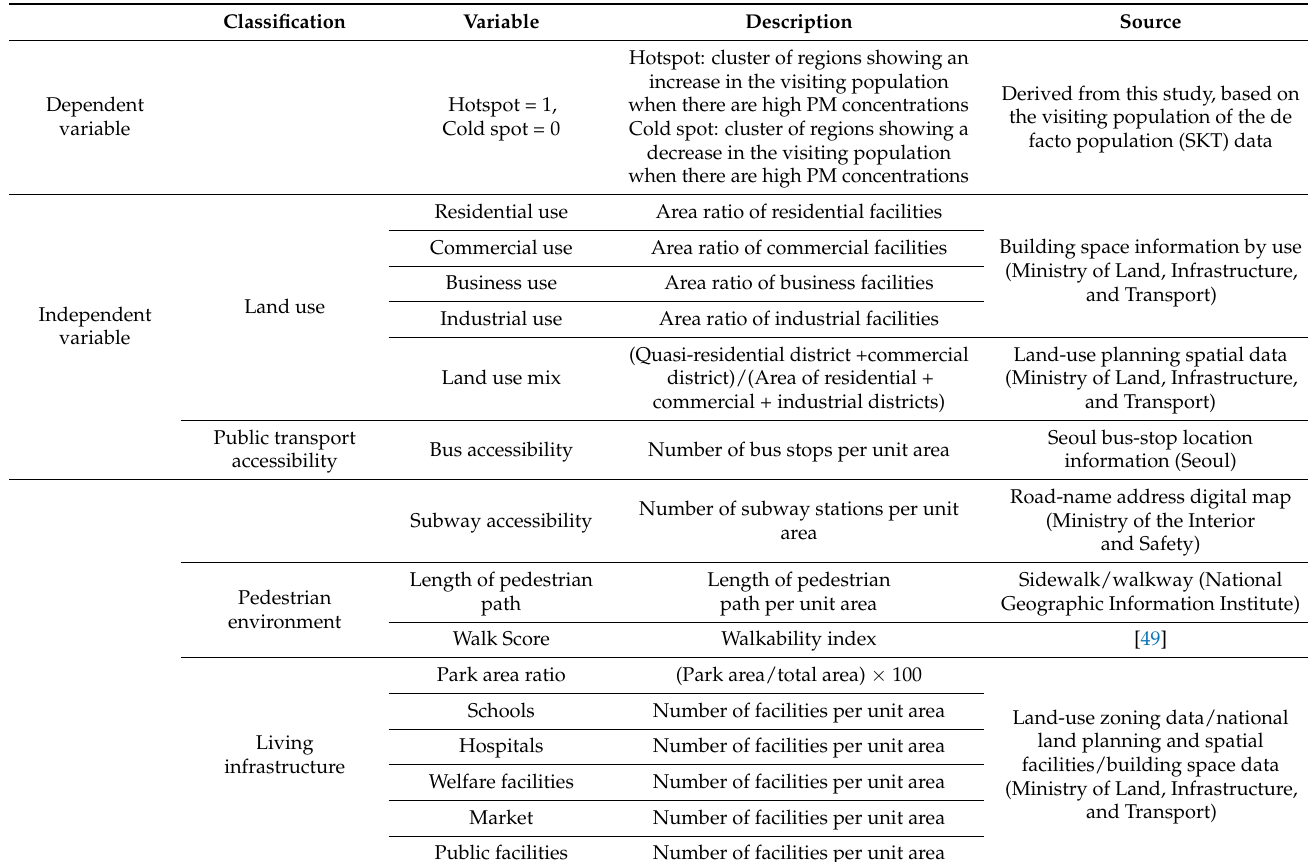
Table 2. Variables of the logistic regression